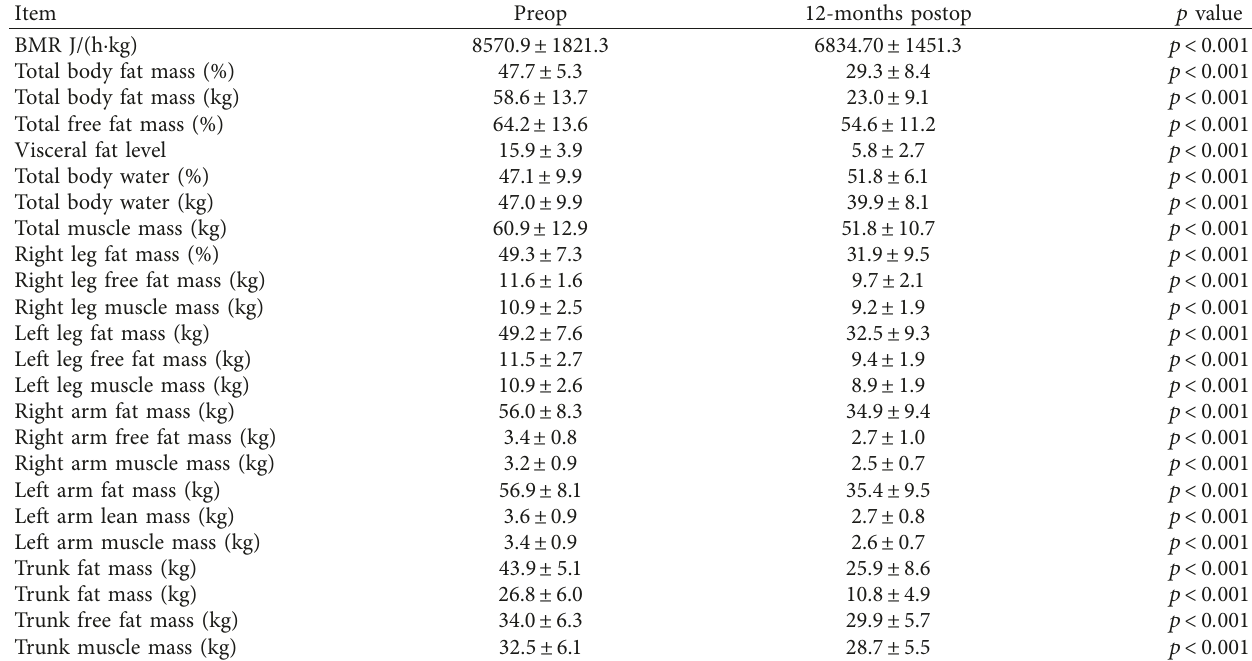
Table 2: Changes of bioelectrical impedance analysis at the end of the study.